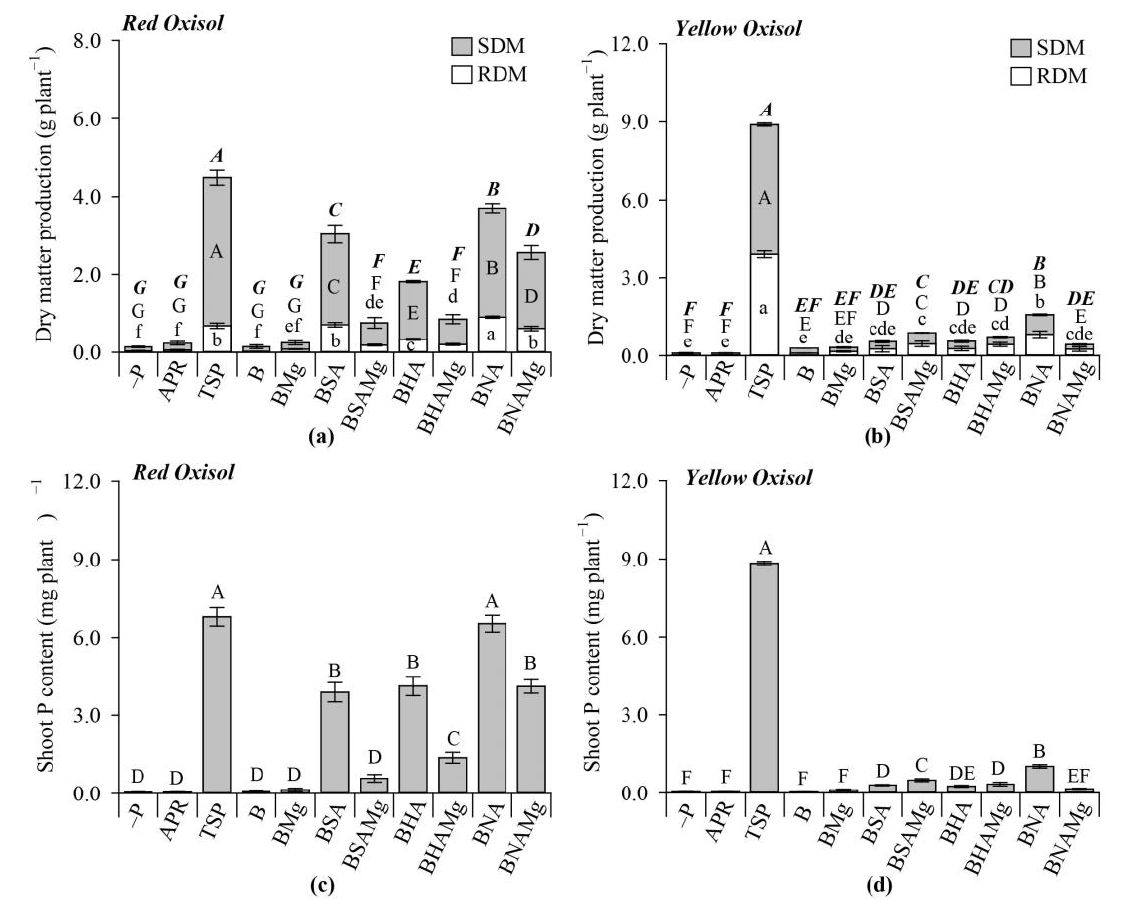
Figure 8. Biomass production ( a, b ) and phosphorus (P) accumulated ( c, d ) in brachiaria shoot for plants grown in the Red and Yellow Oxisols in sequence to maize cultivation. The bars with standard error followed by the same bold italic, uppercase and lowercase letter did not differ regarding the treatment means, respectively, for total (full bar), shoot (SDM), and root (RDM) dry matter production according to the Duncan test ( p < 0.05). The bars with standard error followed by the same uppercase letter did not differ regarding the treatment means for P accumulated in brachiaria grass shoot according to the Duncan test ( p < 0.05). – P: no P fertilizer supplied to maize plants; TSP: triple superphosphate; APR: Araxá phosphate rock. More details of the BBFS acronyms and synthesis routes are shown in Table 1.